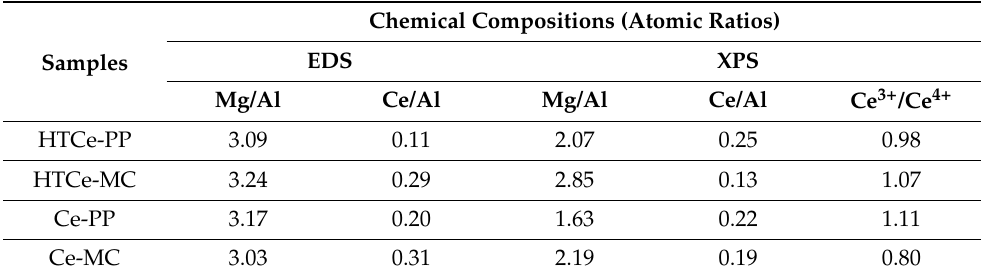
Table 3. Chemical composition of the prepared LDH solids and their corresponding mixed oxides.